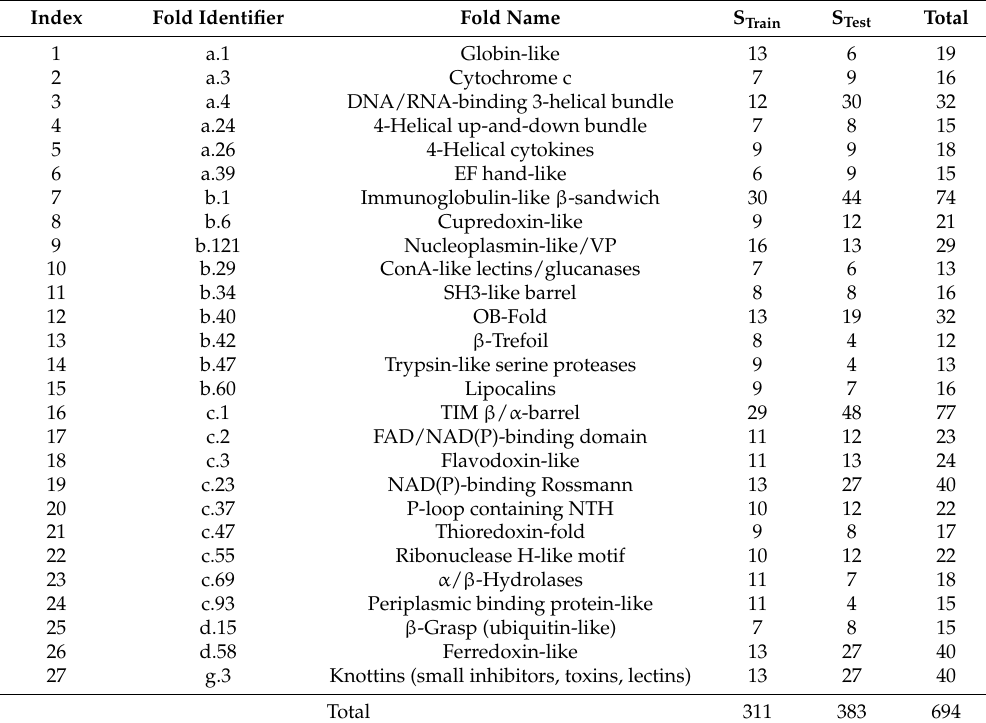
Table 2. Sequence distribution of the 27-fold classes in the DD dataset.